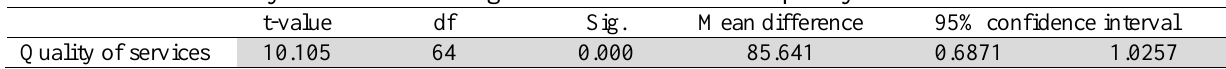
The results of one-way test on measuring the effect of CRM on quality of services. t-value df Sig. Mean difference Quality of